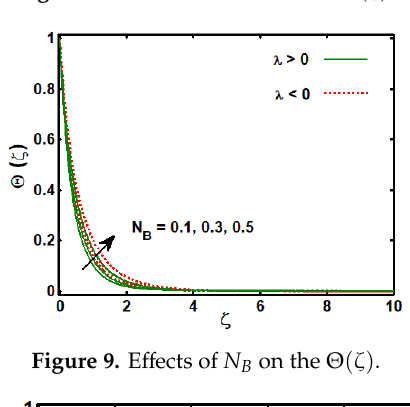
Figure 8. Effects of the M on the 𝛩(𝜁) .